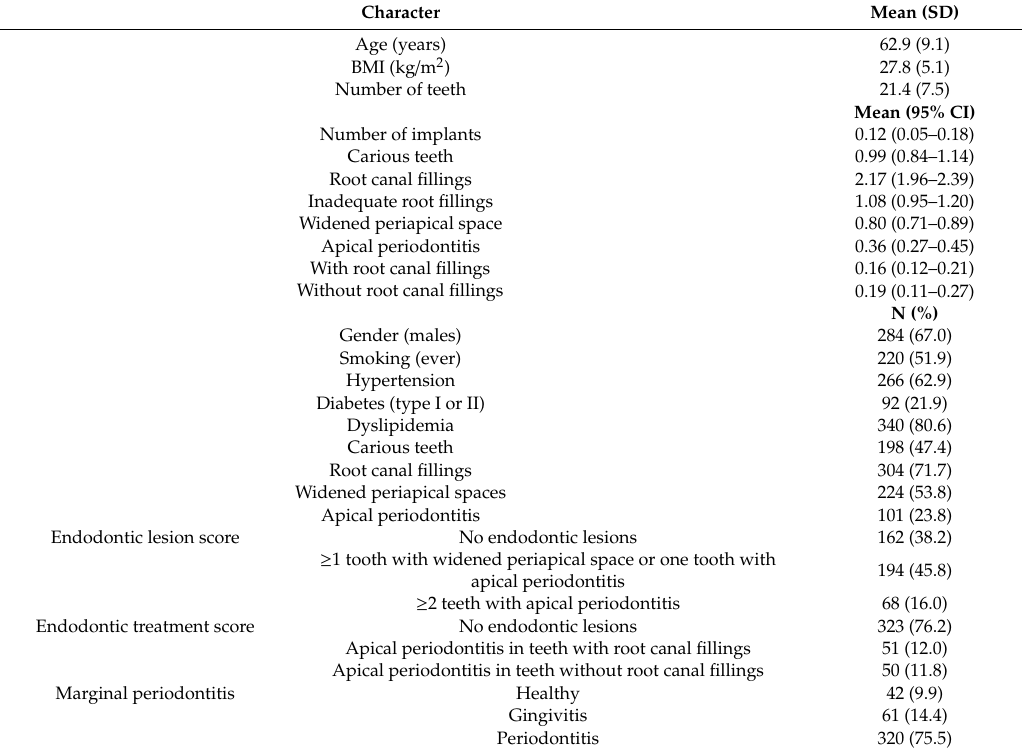
Table 1. Characteristics of the